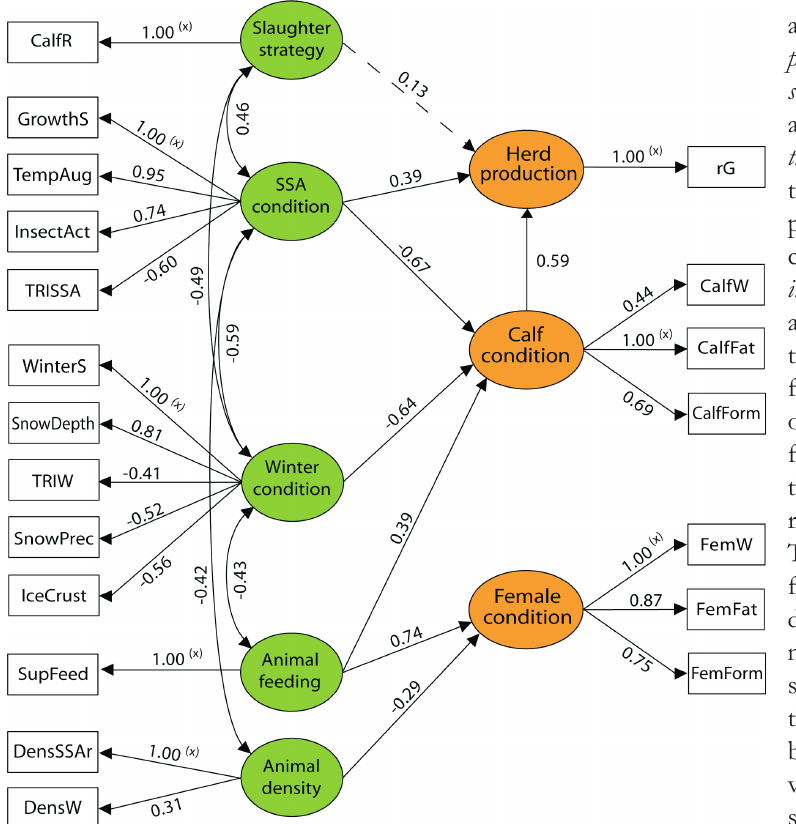
Fig. 2. Estimated parameters of the final structural equation model describ- ing variation between herding districts. Significant ( P ≤ 0.10) path coefficients and covariances between manifest variables (white), exogenous latent variables (green), and endogenous latent variables (orange) are shown as solid arrows while dashed lines were used for the less significant path between Slaughter strat­ egy and Herd Production . Fixed coefficients are marked with (x) and correlations between exogenous latent variables are shown as curved double-head